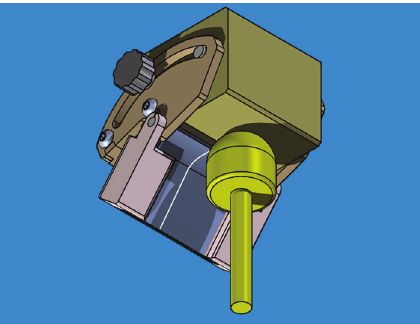
Figure 7: A preliminary, simplified hypothesis for the compliant incisal table, to be mounted on a typical commercial articulator. Curvature can be adjusted by turning a screw and bending the table.